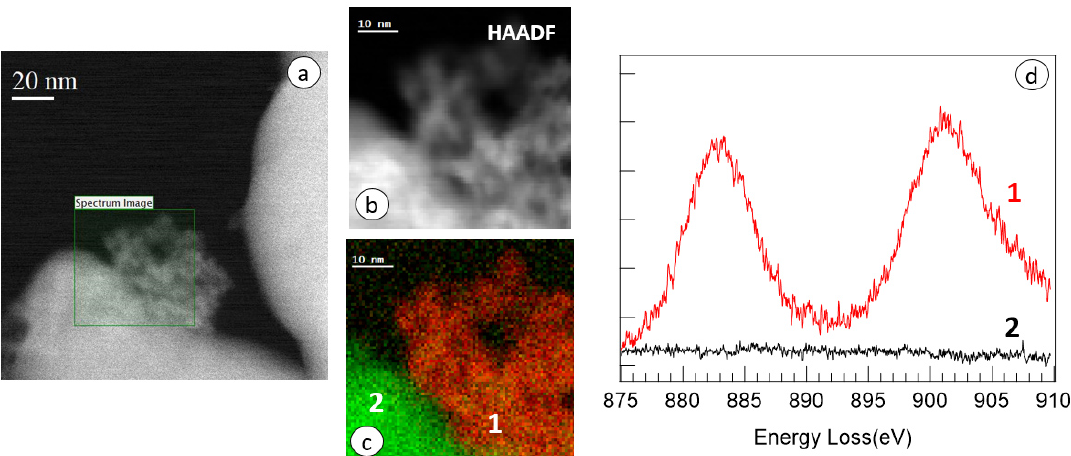
Figure 8. ( a ) High-angle annular dark field (HAADF) image of the ZnO:Ce 2% sample showing the spectrum imaging (SI) area. ( b ) HAADF image simultaneously recorded to the electron energy loss spectroscopy (EELS) acquisition. ( c ) Chemical map, the area in red being where Ce is present. ( d ) EELS spectra extracted from area 1 and